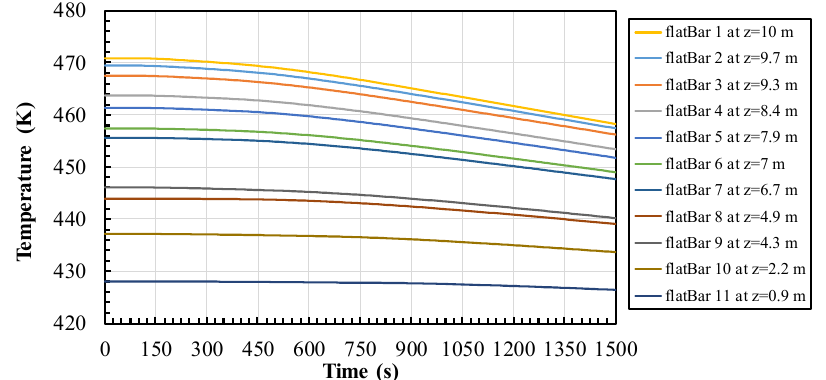
Figure 13. The predicted average temperature on the flat bars by means of the SST k- ω turbulence model with CHT.